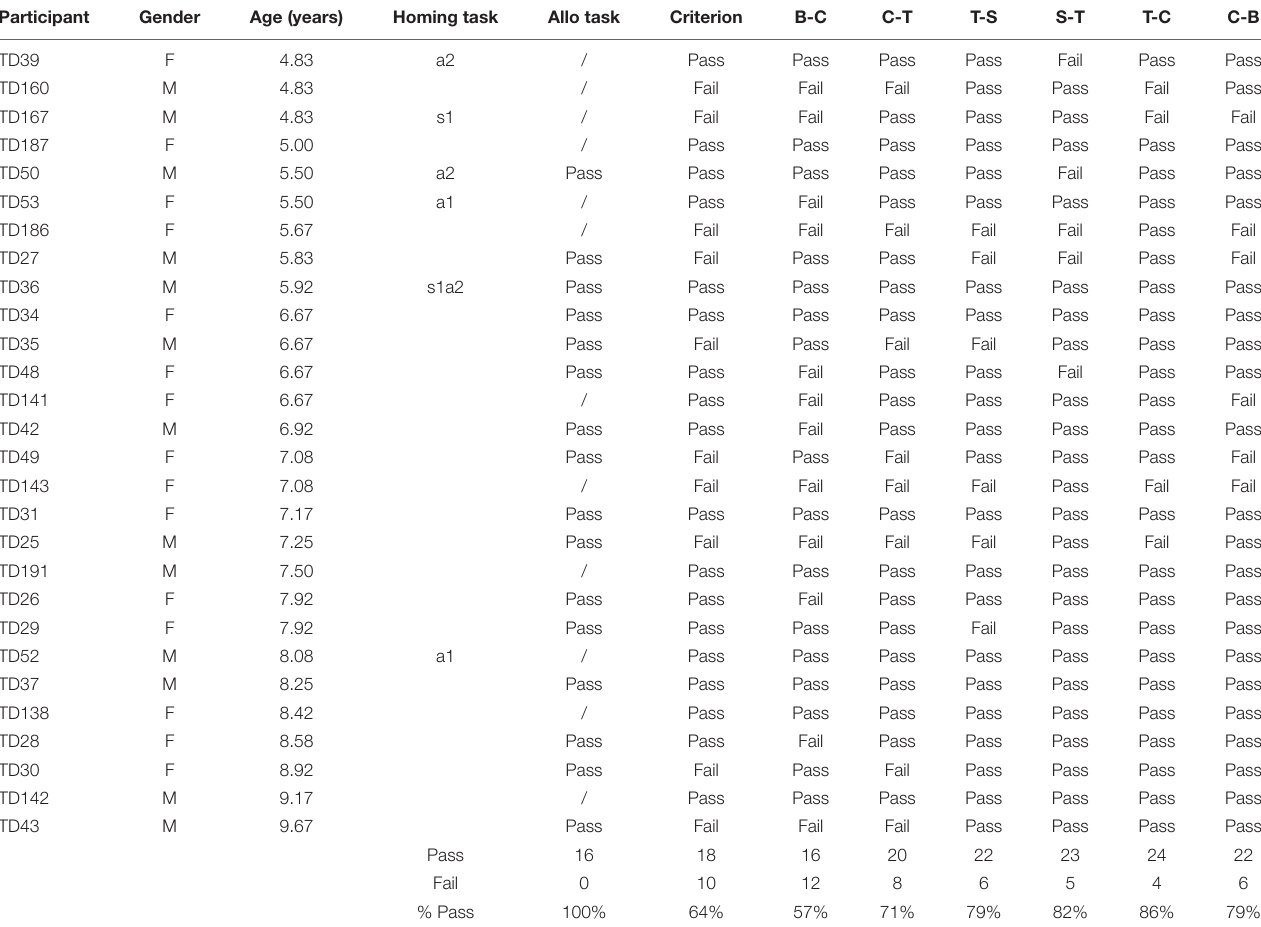
B-C, Bench to Chair; C-T, Chair to Table; T-S, Table to Shelf; S-T, Shelf to Table; T-C, Table to Chair; C-B, Chair to Bench; Homing task, the letter/number indicates sessions in which the participant was considered to have failed; s1, straight session 1; s2, straight session 2; a1, angled session 1; a2, angled session 2. Allo task, performance of participants who were also tested in the open-field allocentric spatial learning task (Bostelmann et al., 2017, 2018): Pass, succeeded at the task; Fail, failed the task; /, not tested. Pass, average final location within the target quadrant; Fail, average final location not within the target quadrant. Criterion: 4 paths passed, including the C-T and the T-C